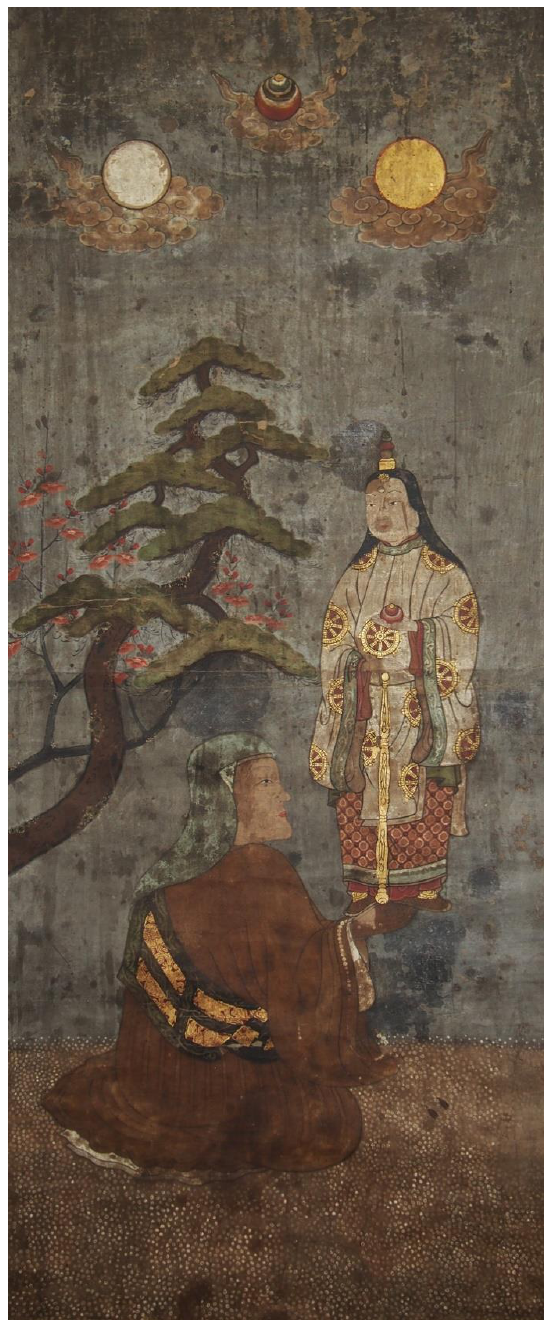
Figure 1. Keikōin Nun and Uhō Dōji , Edo period, 17th century, hanging scroll, ink and colors on paper, Figure 1. Keik¯oin Nun and Uh¯o D¯oji , Edo period, 17th century, hanging scroll, ink and colors on paper, 34 × 81 cm. Gakushūin University, Tokyo. 34 × 81 cm. Gakush¯uin University,